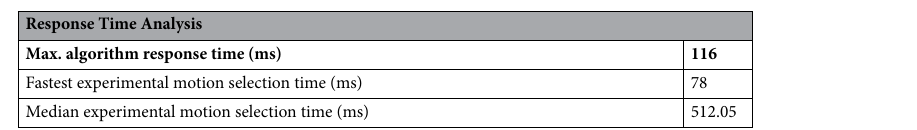
Table 2. Summary of the system response time evaluation results. The algorithm’s theoretical response time under ideal conditions is 116 ms. Experimentally, sensor noise and the user’s voluntary contraction time contribute to the motion selection time, which has been measured at median of 515.9 ms with this study’s